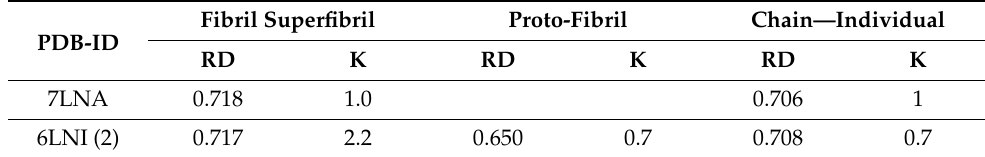
Table 7. Status of fragments delimited by